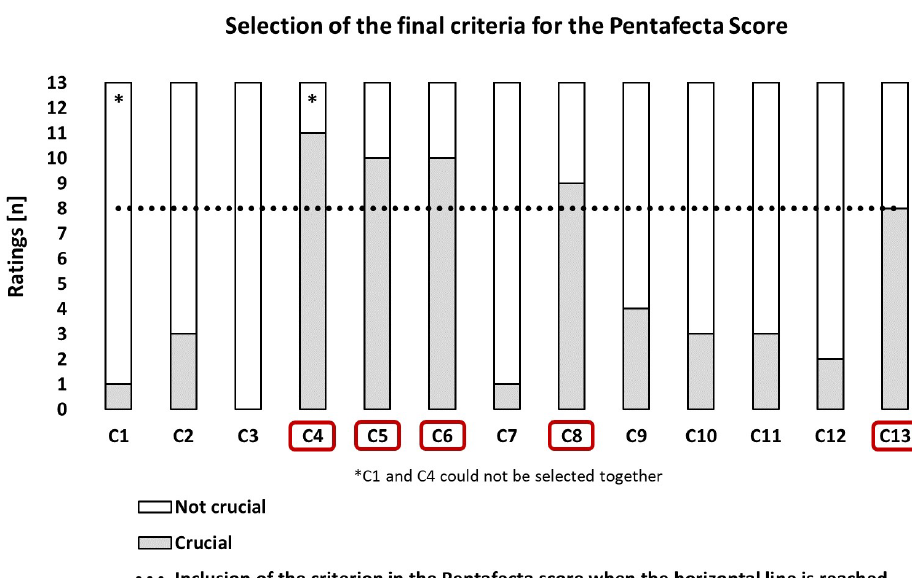
Figure 1. Formation of the final Pentafecta score based on the ratings of 13 experts on 13